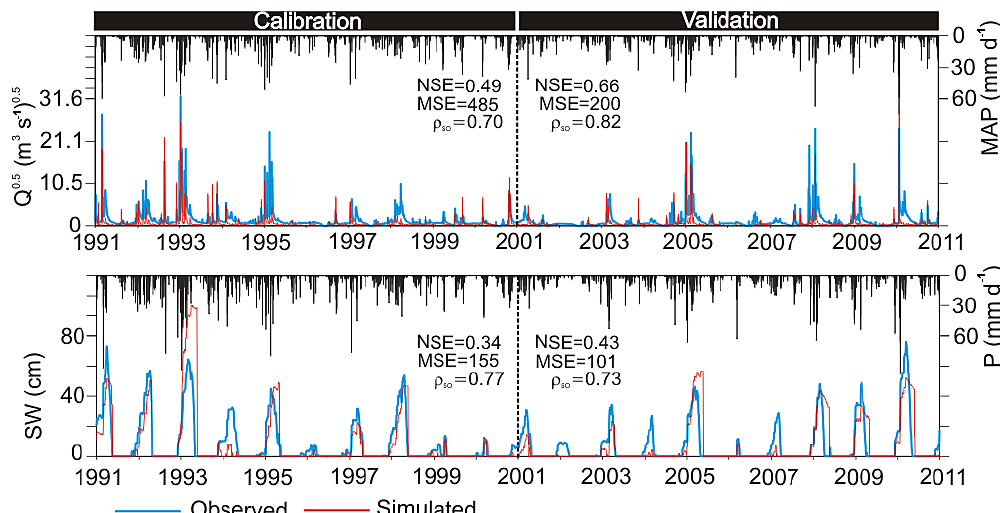
Figure 7. Observed (blue lines) and simulated (red lines) hydrograph and snow water equivalent time series resulting from model calibration (1991–2000) and validation (2001–2010) at the basin outlet and collocated snow station model Voronoi element (shown in Fig. 4), along with NSE, MSE and ρ so skill scores. To improve the visualization of low streamflow values, the time series of discharges have been elevated to a 0.5 exponent. Mean Areal and pixel Precipitation (MAP and P , respectively) are derived from the corrected NLDAS product. Table 3. Description of reference case (Ref) and hydrologic simulation (V, VS10, VS20, VS40) scenarios in terms of modifications in forest and soil properties.